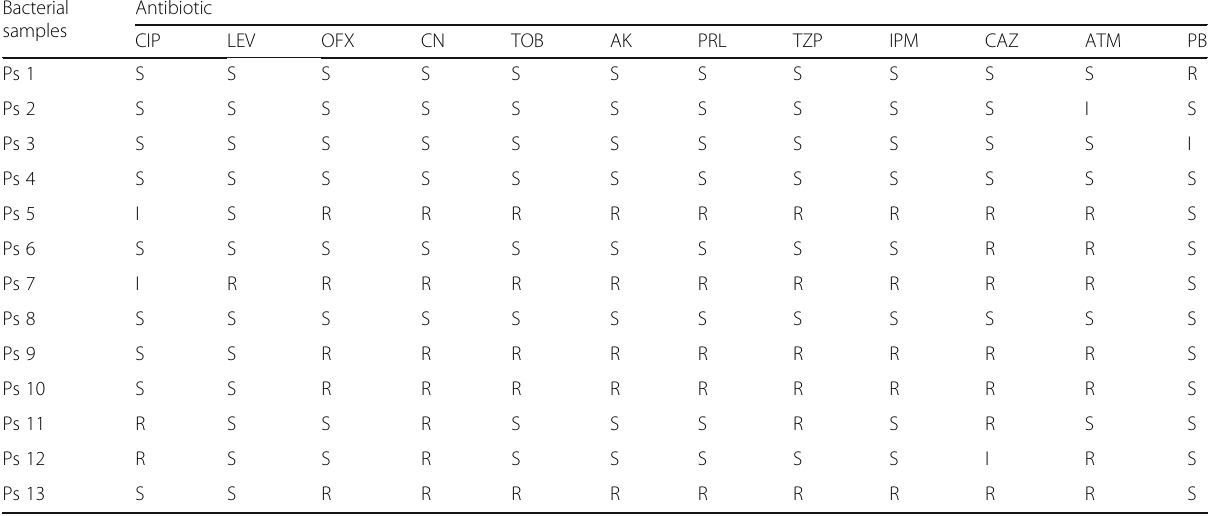
Table 2 Susceptibility test of the studied Pseudomonas aeruginosa (Ps) isolates against standard antibiotics Bacterial Antibiotic samples